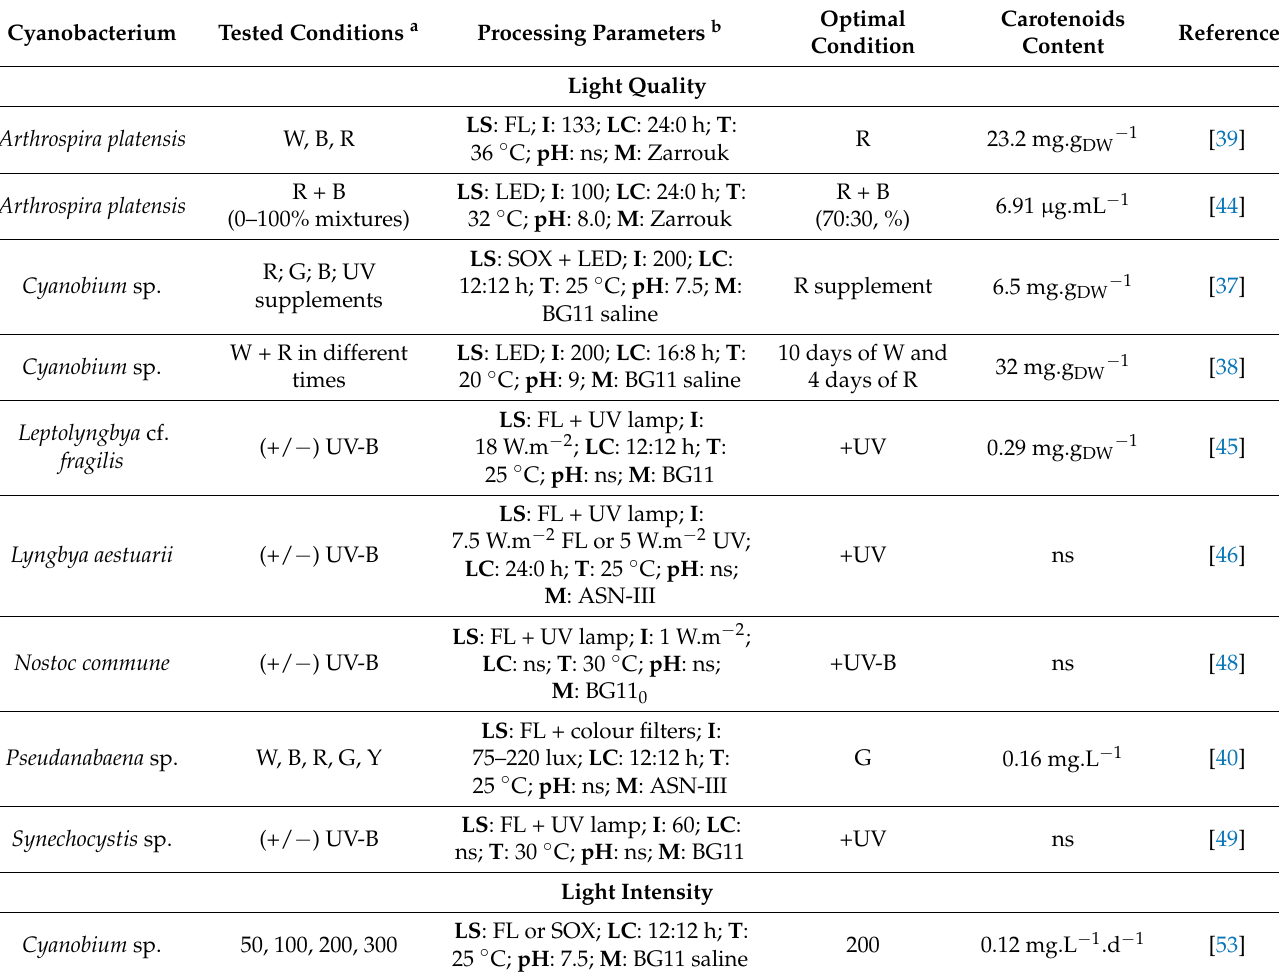
Table 2. Effects of light quality and intensity on the production of carotenoids by cyanobacteria. Processing parameters include: light source (LS) and intensity (I), light:dark cycle (LC), temperature (T), pH, and culture media (M). Light intensity is expressed in µ mol photons .m − 2 .s − 1 unless another unit is